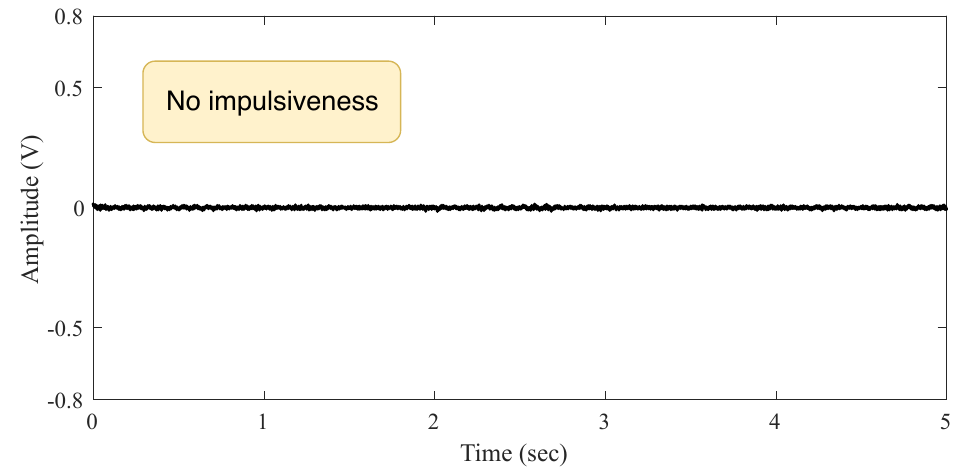
Figure 3. Signal behavior in the indoor scenario without audio source.